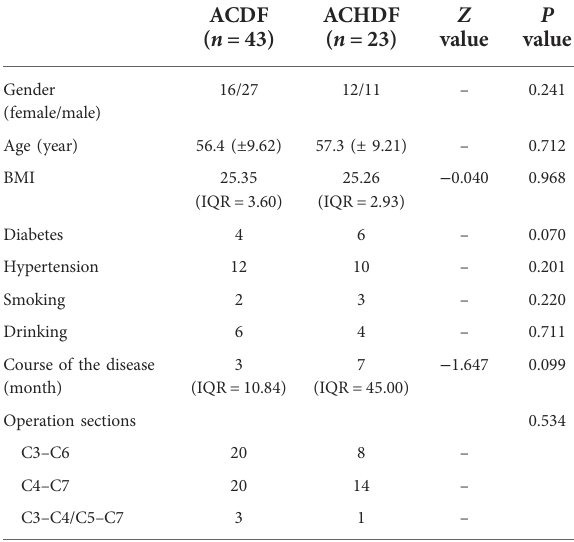
TABLE 1 Comparison of general data between the two groups of ACDF and